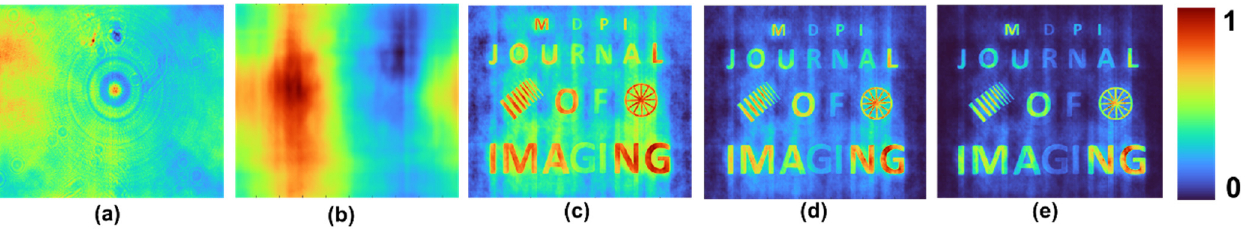
Figure 14. ( a ) Recorded PSF, ( b ) object’s response pattern. Reconstruction results using ( c ) NLR ( p = 1), ( d ) NLR ( p = 2) and ( e ) NLR ( p = 3) for FINCH with random multiplexing configuration.